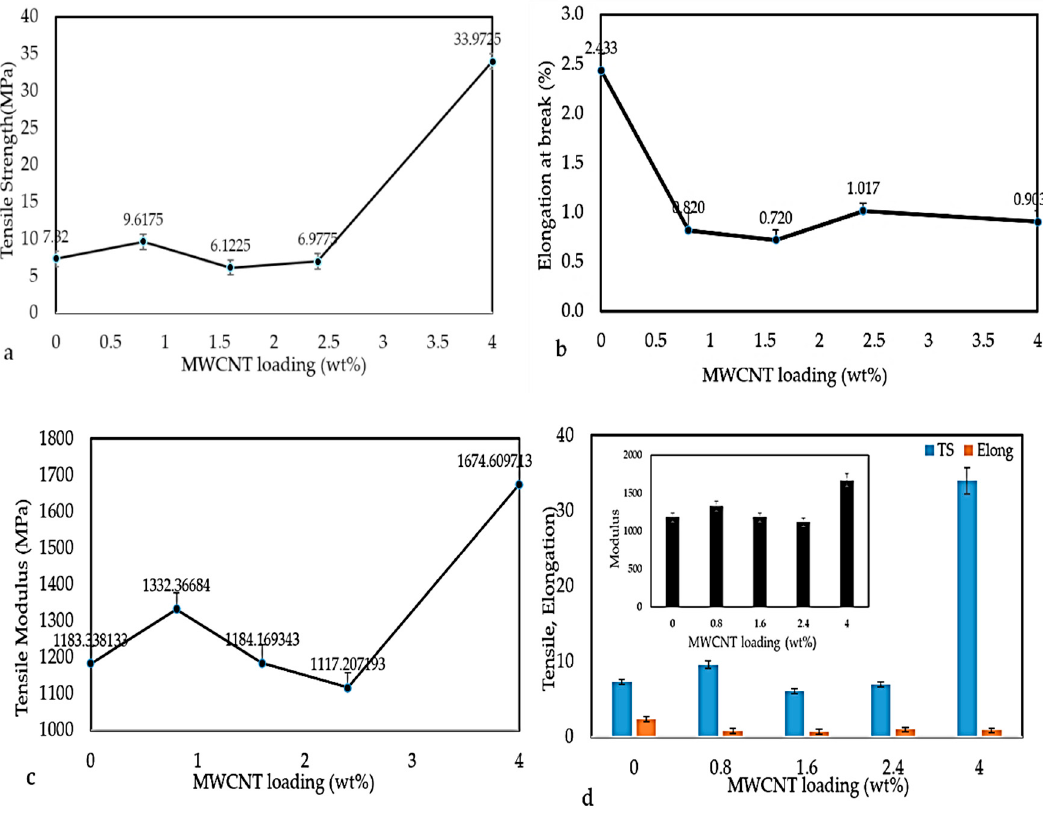
Figure 9. Variation in ( a ) Tensile strength, ( b ) Elongation at break, ( c ) Tensile modulus, and ( d ) Effect of MWCNTs content on a tensile strength (TS), elongation at break (EB), and tensile modulus (TM).